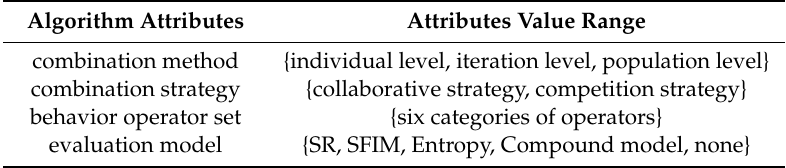
Table 1. Multi-behavior combination algorithm